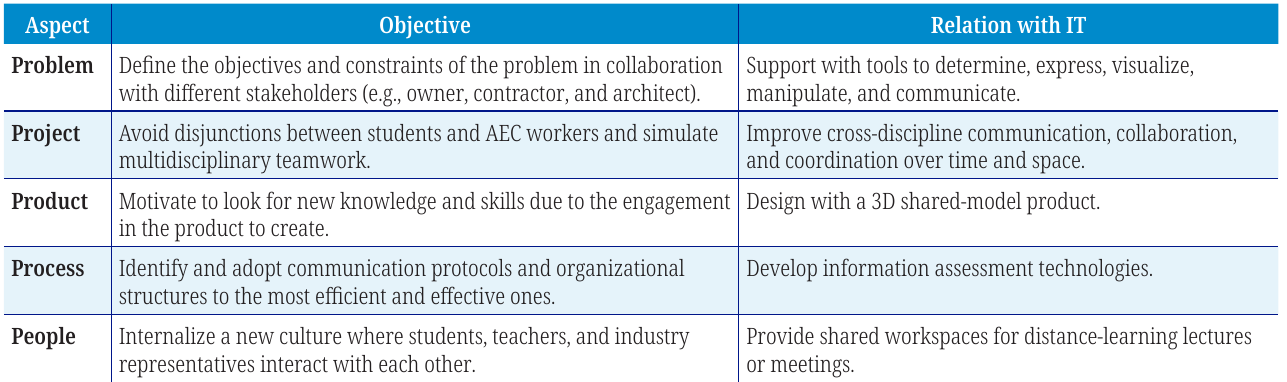
Table 2. Problem-, project-, product-, process-, and people-based learning Aspect Objective Relation with IT Problem Define the objectives and constraints of the problem in collaboration Support with tools to determine, express, visualize, with different stakeholders (e.g., owner, contractor, and architect). manipulate, and communicate. Project Avoid disjunctions between students and AEC workers and simulate Improve cross-discipline communication, collaboration, multidisciplinary teamwork. and coordination over time and space. Product Motivate to look for new knowledge and skills due to the engagement Design with a 3D shared-model product. in the product to create. Process Identify and adopt communication protocols and organizational Develop information assessment technologies. structures to the most efficient and effective ones. People Internalize a new culture where students, teachers, and industry Provide shared workspaces for distance-learning lectures representatives interact with each other. or